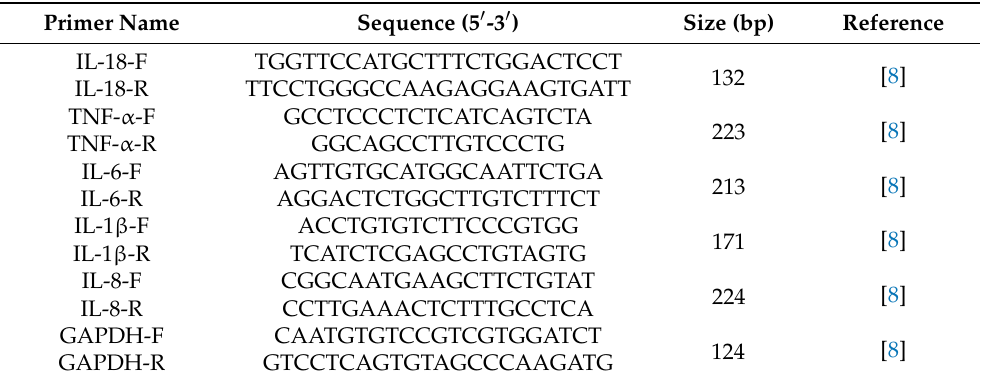
Table 5. The primers of five cytokines for qPCR